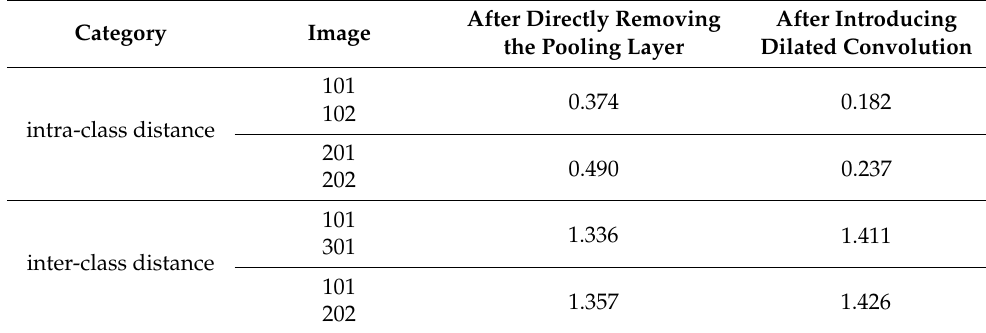
Table 3. Comparison of network performance before and after the introduction of dilated convolution.